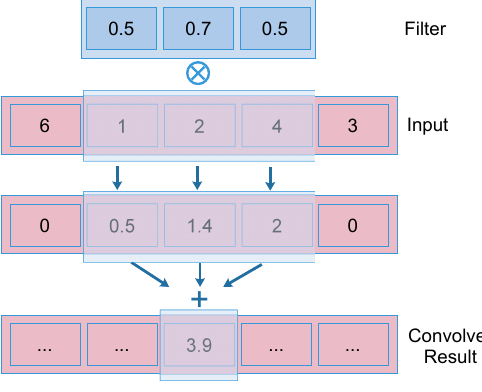
Figure 3. 1D convolution